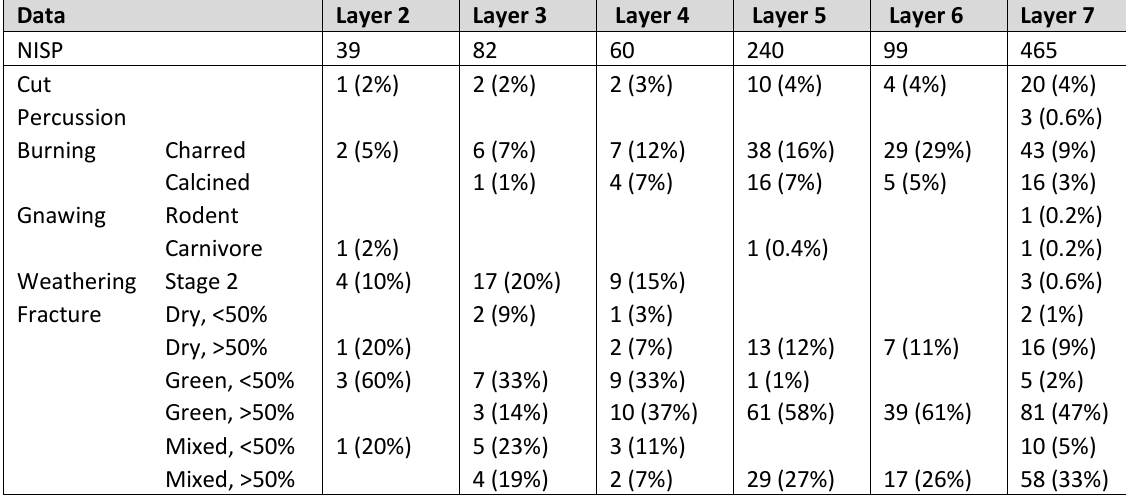
Table 1: Bone surface modifications and fracture morphology at NR2. Percentages were calculated out of the NISP, except for the fracture morphology where percentages were calculated out of the sum of observed fracture